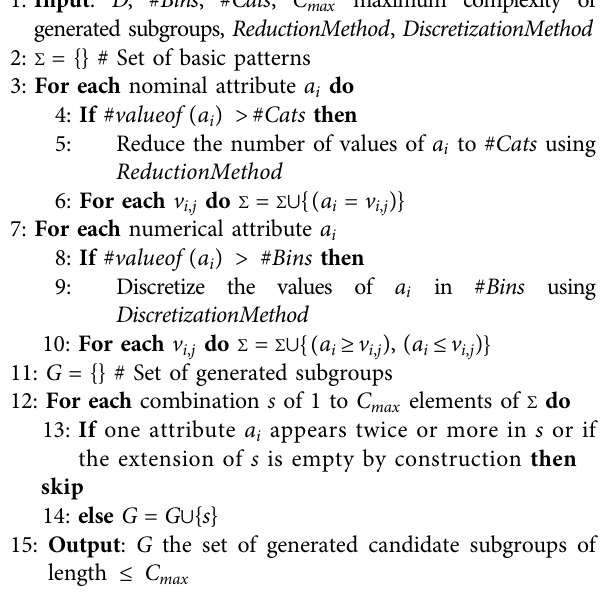
Algorithm 1 : Basic patterns and candidate subgroup generation of complexity ≤ C